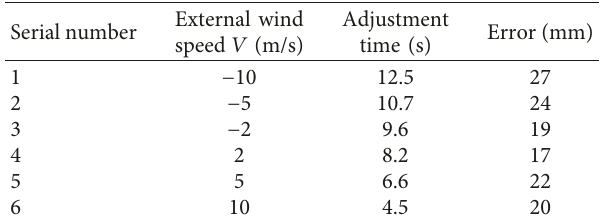
Figure 3: Yaw angle output curve of the attitude control Table 1: Relative parameters of position control experiment under external wind disturbance.